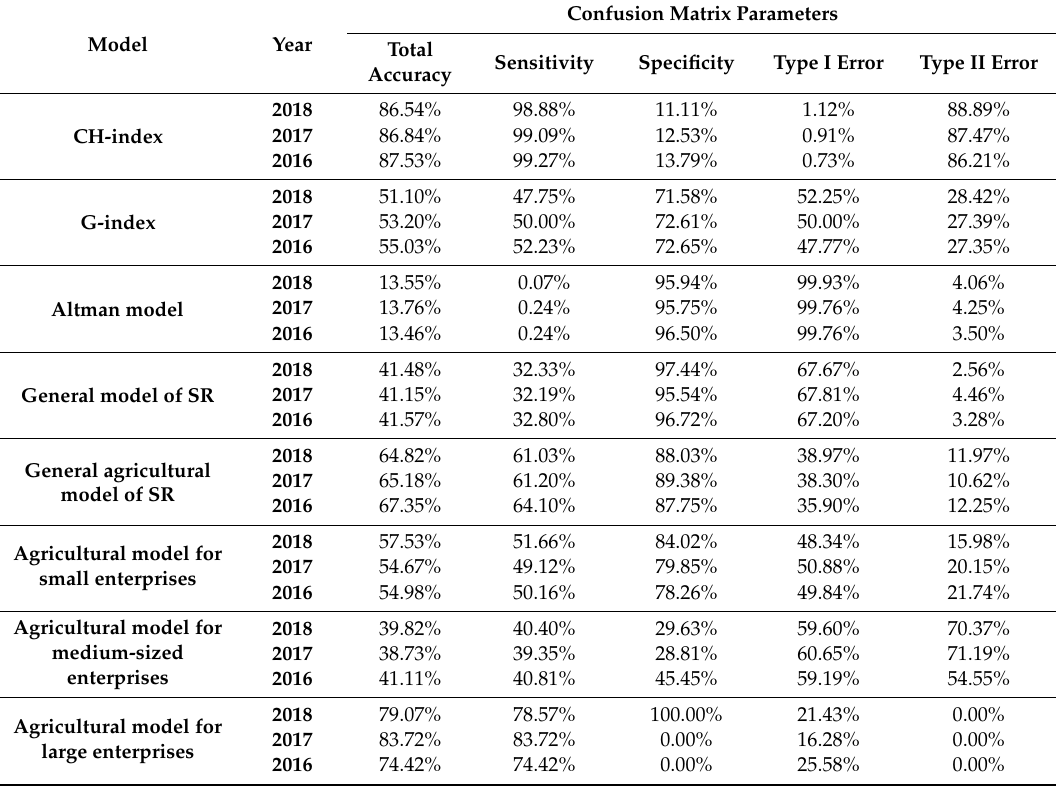
Table 5. Prediction accuracy of models measured by confusion